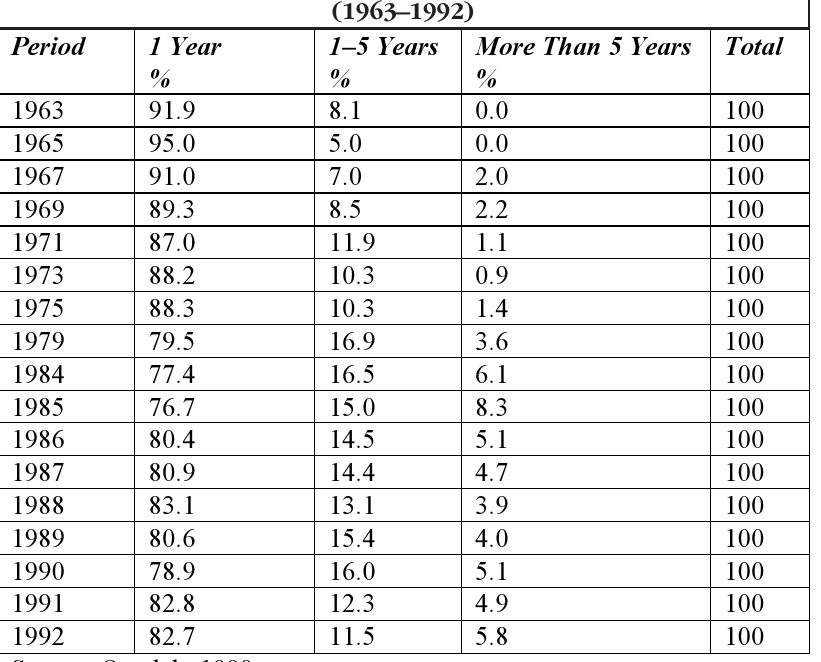
Table 7. Maturity Pattern of Commercial Banks Loans and